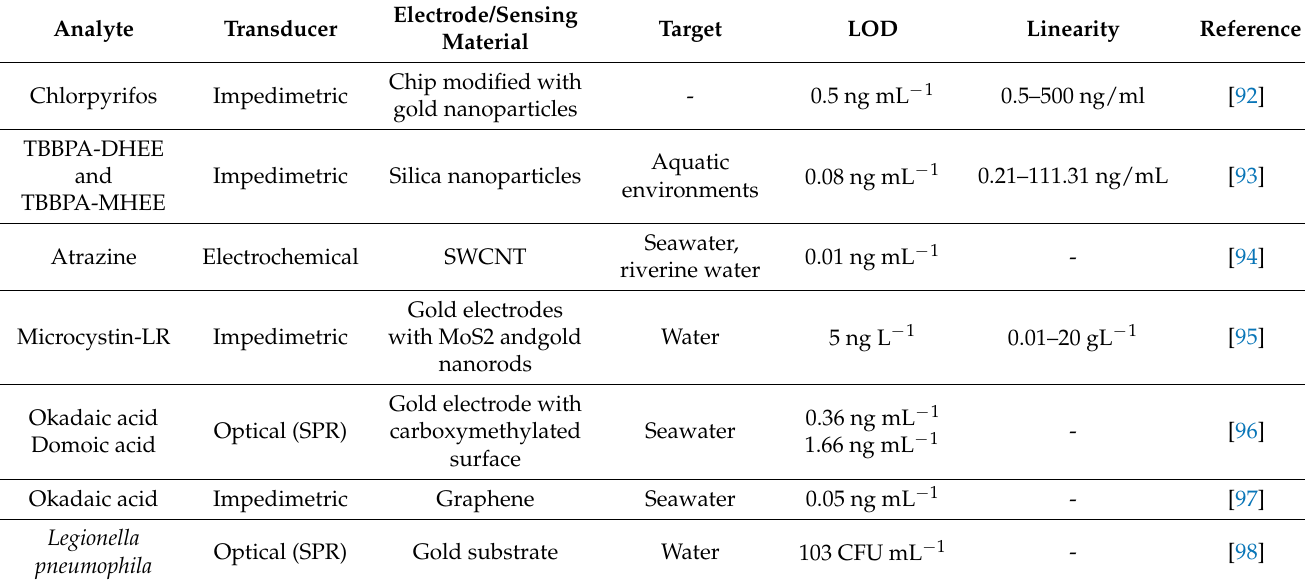
Table 4. Examples of immunosensors used for environmental